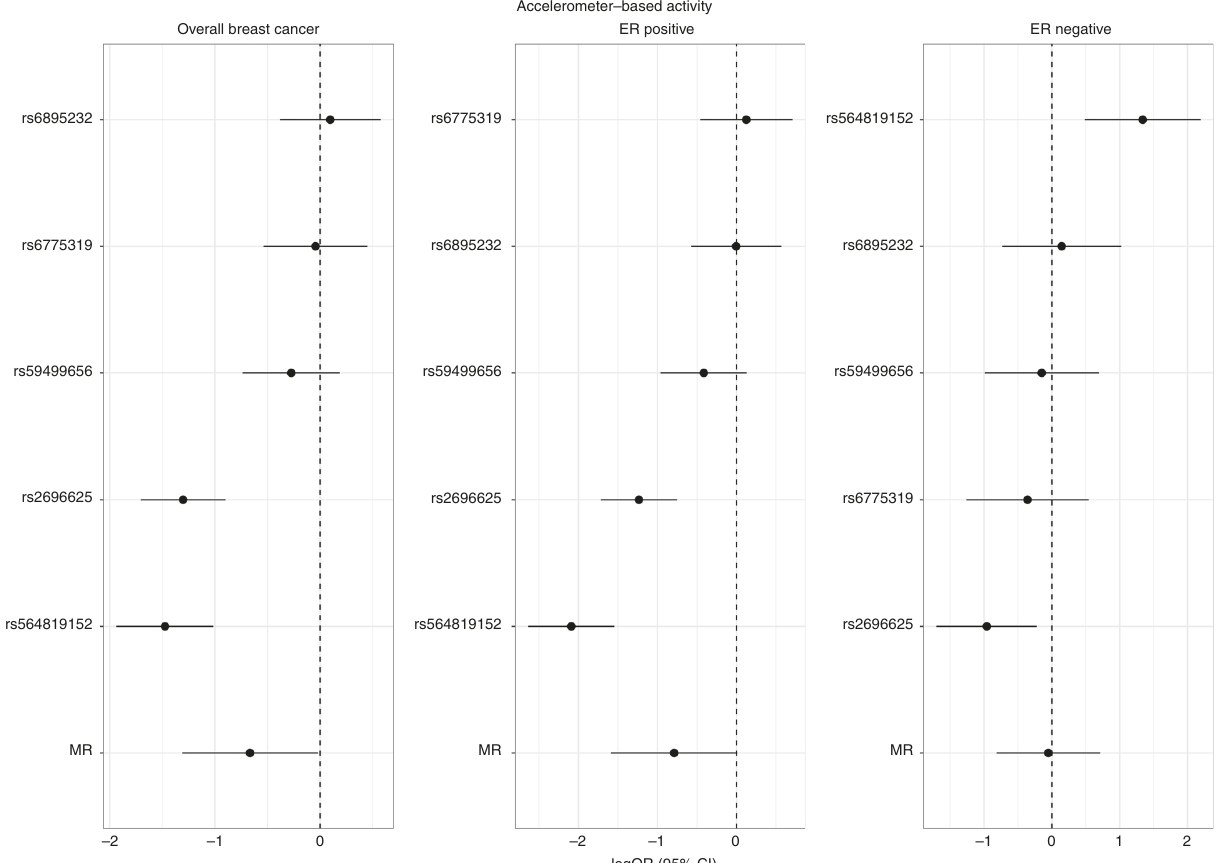
Fig. 1 Mendelian randomisation analysis for individual SNPs associated with accelerometer-measured physical activity in relation to breast cancer risk using the genetic instrument from the GWAS by Doherty et al. 11 . The x axis corresponds to a log OR per one unit increase in the physical activity based on the average acceleration (milligravities). The Mendelian randomisation (MR) result corresponds to a random effects model due to heterogeneity across the genetic instruments. logOR = log odds ratio (black fi lled circle). 95% CI = 95% con fi dence interval (black line). SNP single nucleotide